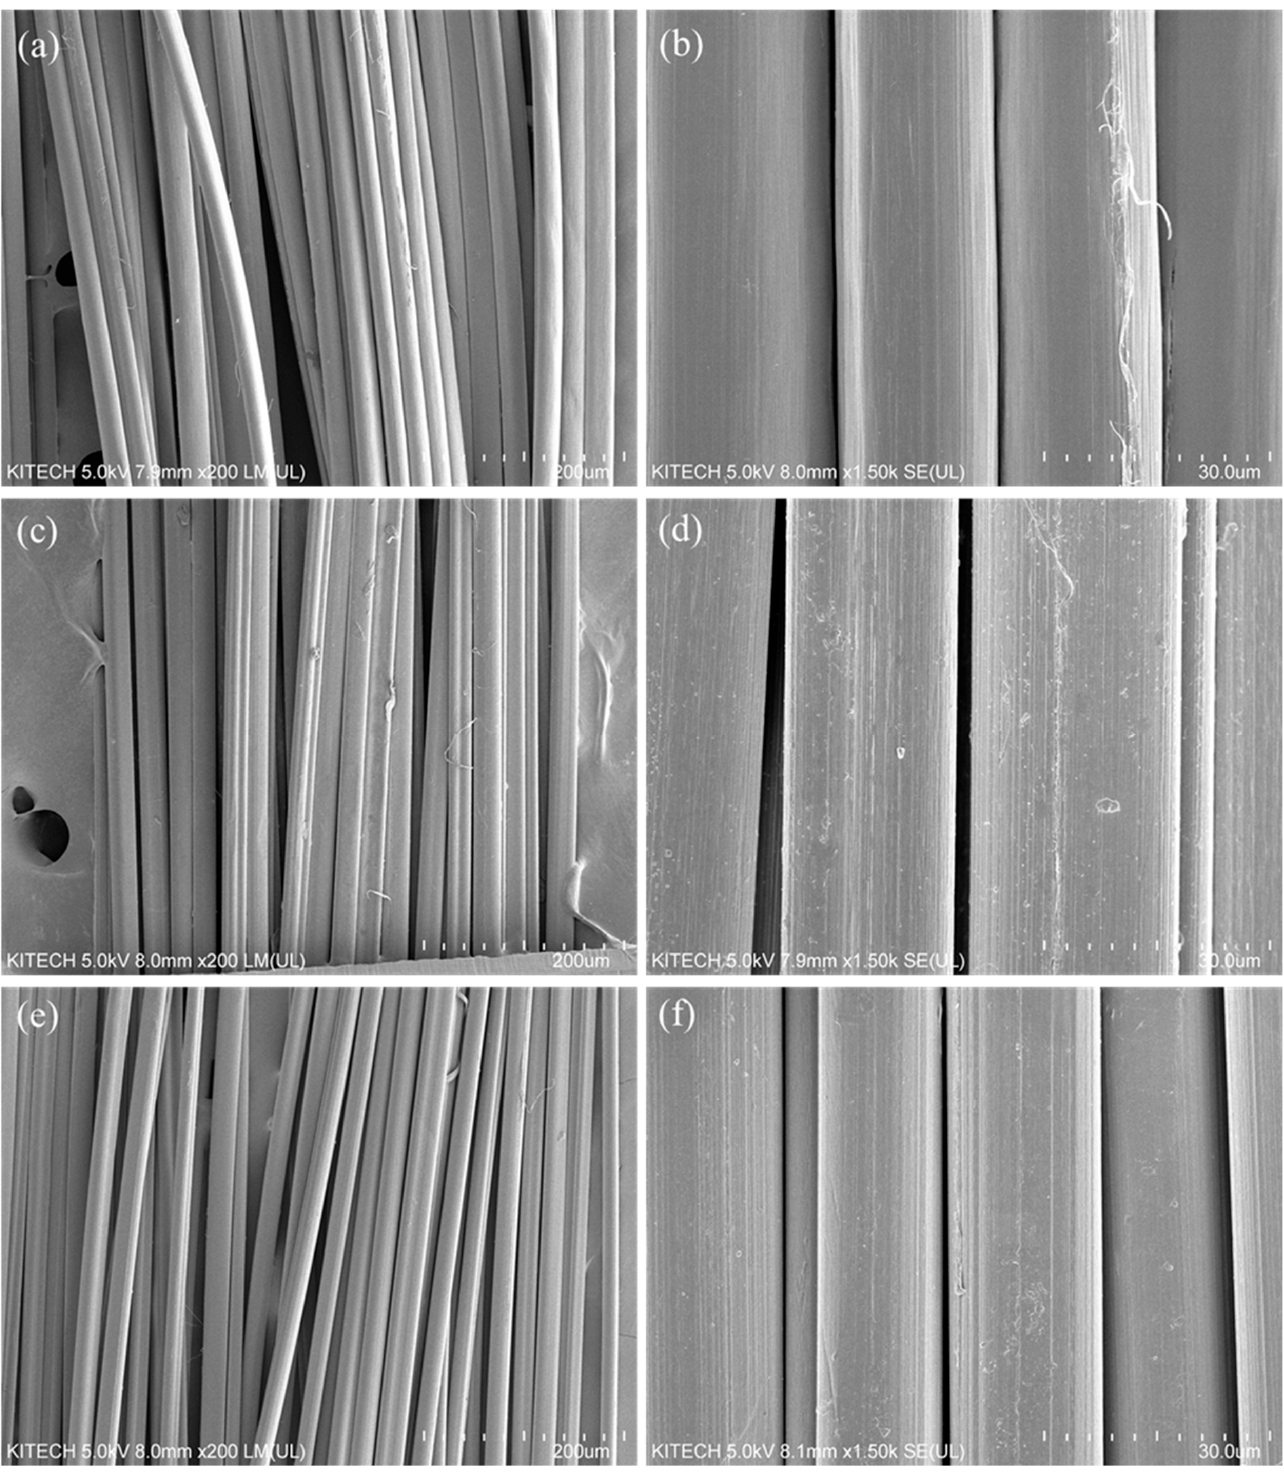
Figure 5. Scanning electron microscopy (SEM) images of drawn P (AN-MA) precursor fibers; ( a , b ) LPAN, ( c , d ) MPAN, and ( e , f ) HPAN.